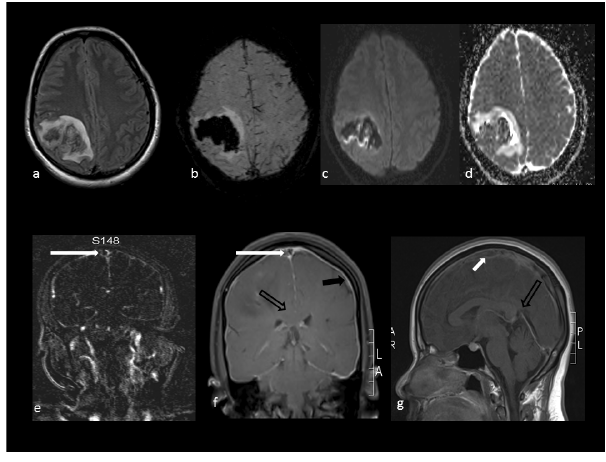
Figure 2. MR imaging. a -Flair, b -SWI, c -DWI map, d -ADC map show right high parietal hematoma without diffusion restriction; e -MR venogram shows thrombus in the sagittal sinus thrombus (white solid arrow); f -post-contrast T1W coronal sequence shows enhancement of the pachymeninges (black solid arrow), sagging of the corpus callosum (black open arrow) and filling defect of the sagittal sinus (white solid arrow); g -post-contrast T1W sagittal sequence shows thrombus in the sagittal sinus (white solid arrow) and narrowing of angle between the vein of Galen and straight sinus (black open